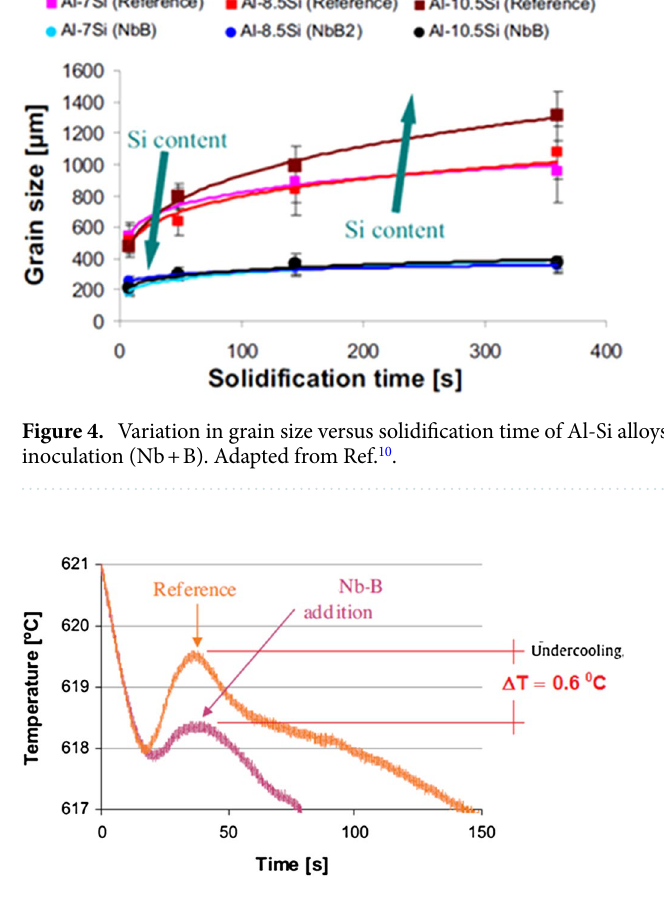
Figure 5. Comparison of the cooling curve of the Al-Si alloy, with and without Nb + B. Adapted from Ref. 14